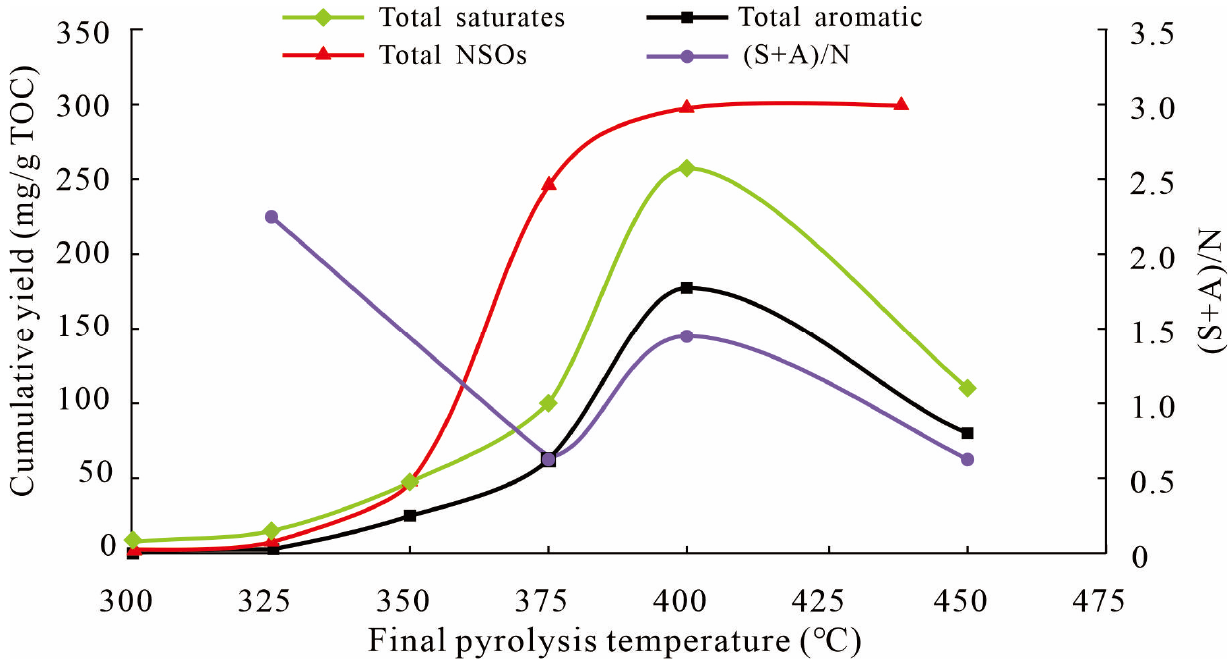
Figure 10. Evolution of total group fractions of liquid hydrocarbons with increase in thermal stress.